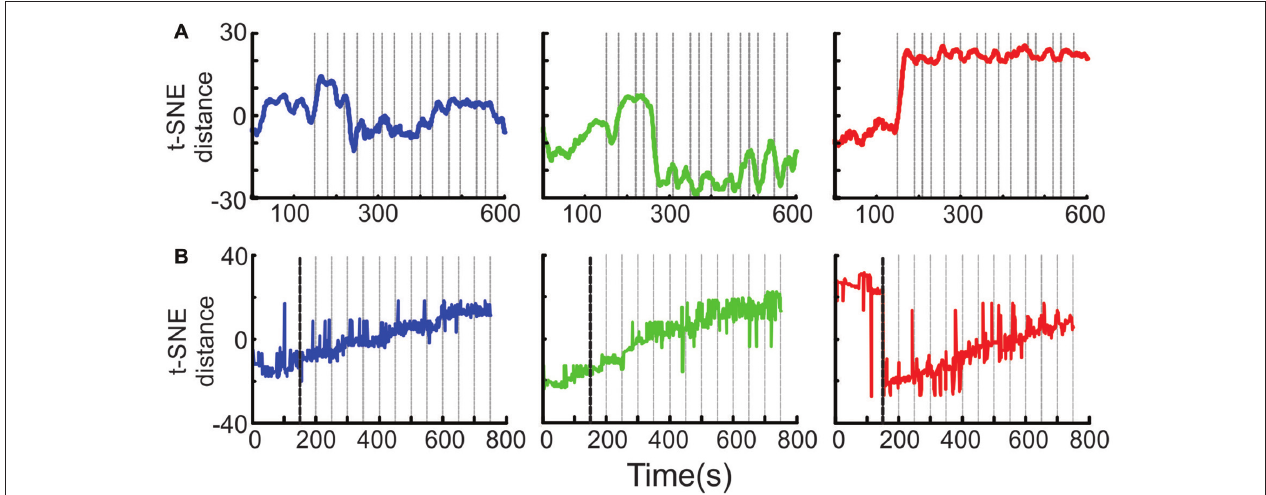
FIGURE 7 | Ensemble transition dynamics. (A) The full MSUA space from a single session ( n = 65 neurons) was reduced to a single dimension using t-SNE which provided a distance metric of how the ensemble activity changed through time starting from the 150 s period preceding block onset through the first 15 trials of the N-block (left, blue), F-block (middle, green) or S-block (right red). The gray lines denote the time of tone onset. The raw t-SNE data was smoothed by a 20 bin rolling average. (B) The full multi-dimensional MSUA space that included all neurons in 13 sessions was reduced to a single dimension using t-SNE. Since multiple sessions with different trial times were combined, the gray lines represent the average time of tone onset (i.e., every 50 s).